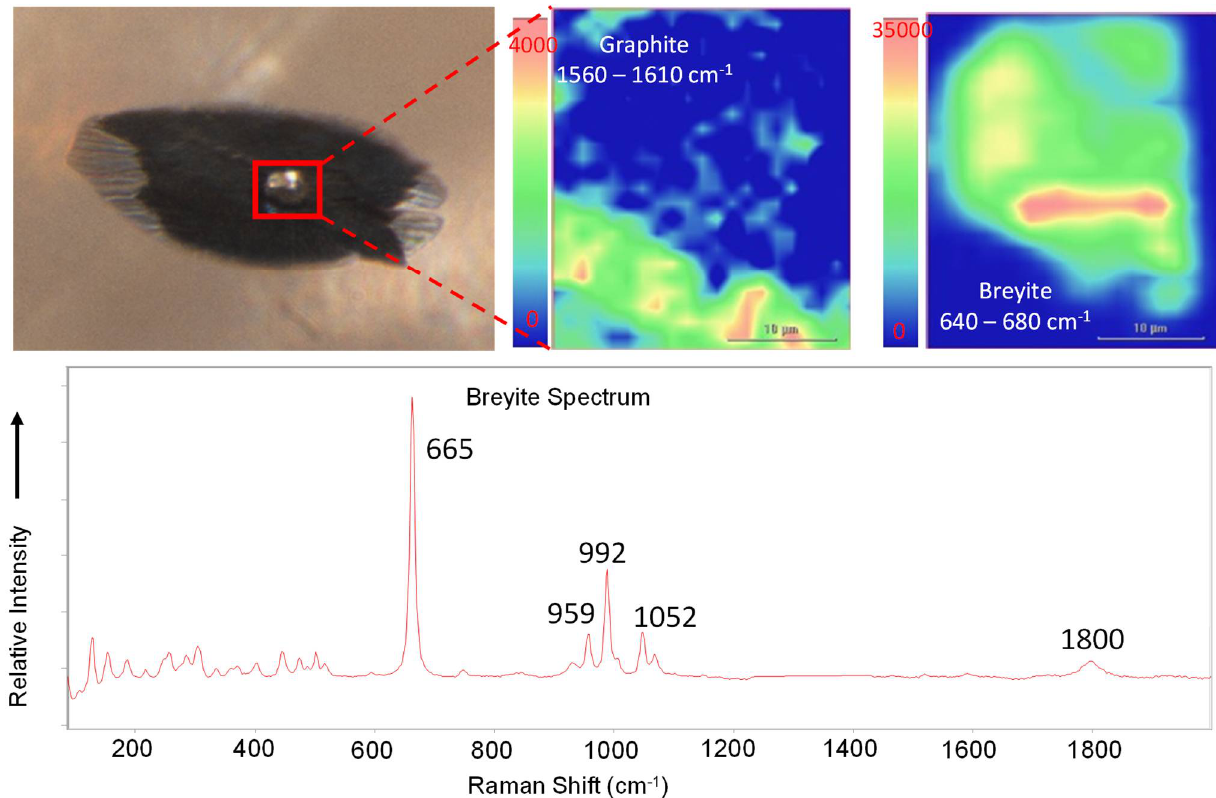
Figure 11. Top left: Photomicrograph of the breyite inclusion located within a type IIa pink diamond; the red box shows the area being mapped. Top center: False color map showing the spatial distribution of graphite around the breyite inclusion. Top right: False color map showing the spatial distribution of the 640–680 cm −1 peak found in the breyite spectra. Bottom: Raman spectrum showing the identification of the breyite inclusion within the image.